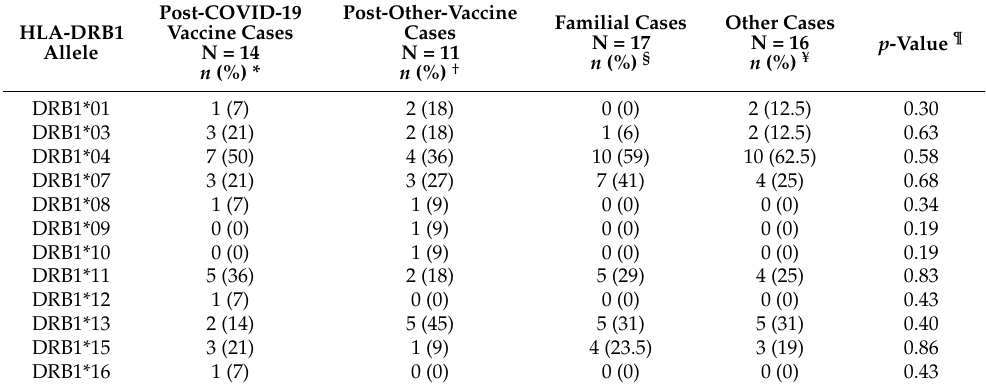
Table 3. Typing in 58 patients—50 with GCA and 8 with PMR, under various circumstances of onset. Post-COVID-19 HLA-DRB1 Vaccine Allele